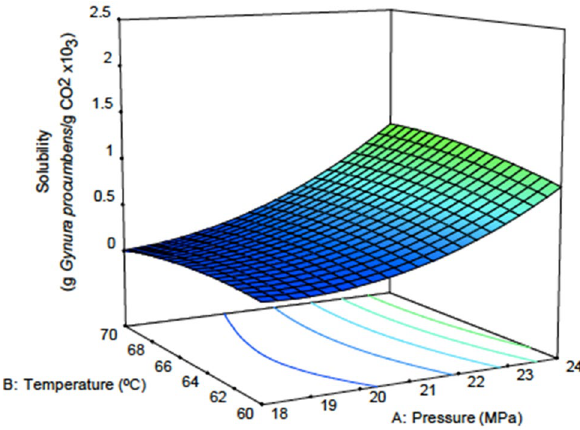
Figure 2. Response surface plot for solubility versus temperature and pressure.